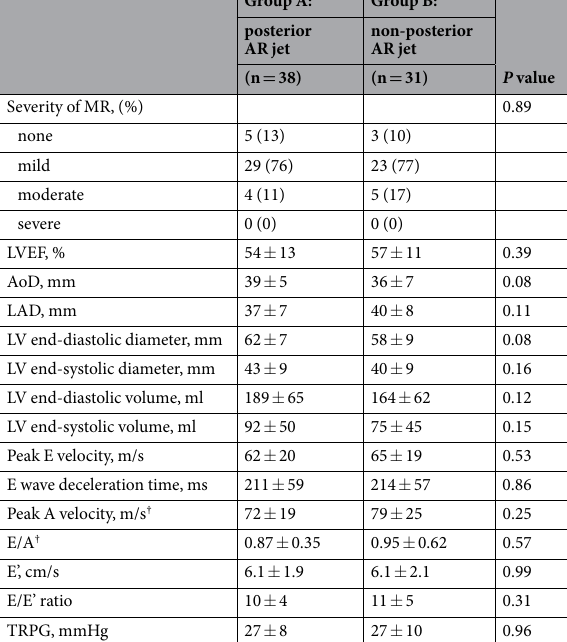
Table 2. Two-dimensional transthoracic echocardiographic characteristics. Values are mean ± SD or n (%). † Except for patients with atrial fibrillation. AR, aortic regurgitation; MR, mitral regurgitation; LVEF, left ventricular ejection fraction; AoD, aortic root diameter; LAD, left atrium diameter; LV, left ventricular; TRPG, tricuspid regurgitation pressure